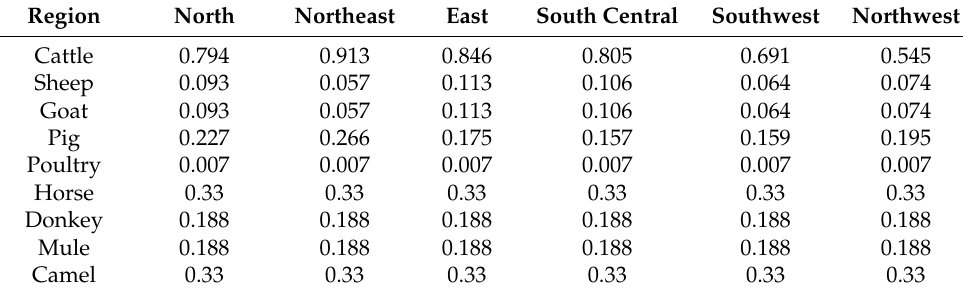
Table 3. Emission factors for livestock and poultry manure in different